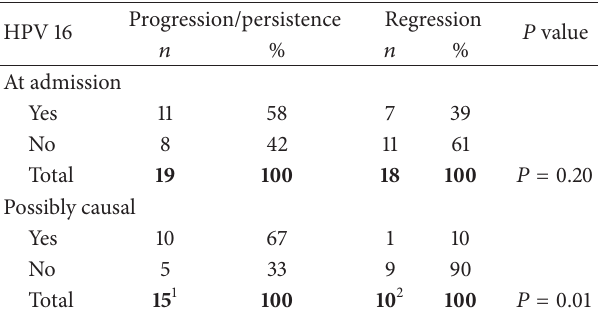
Table 2: Association between HPV 16 at admission and as possibly causal type and clinical outcome of CIN 2 during 12 months of